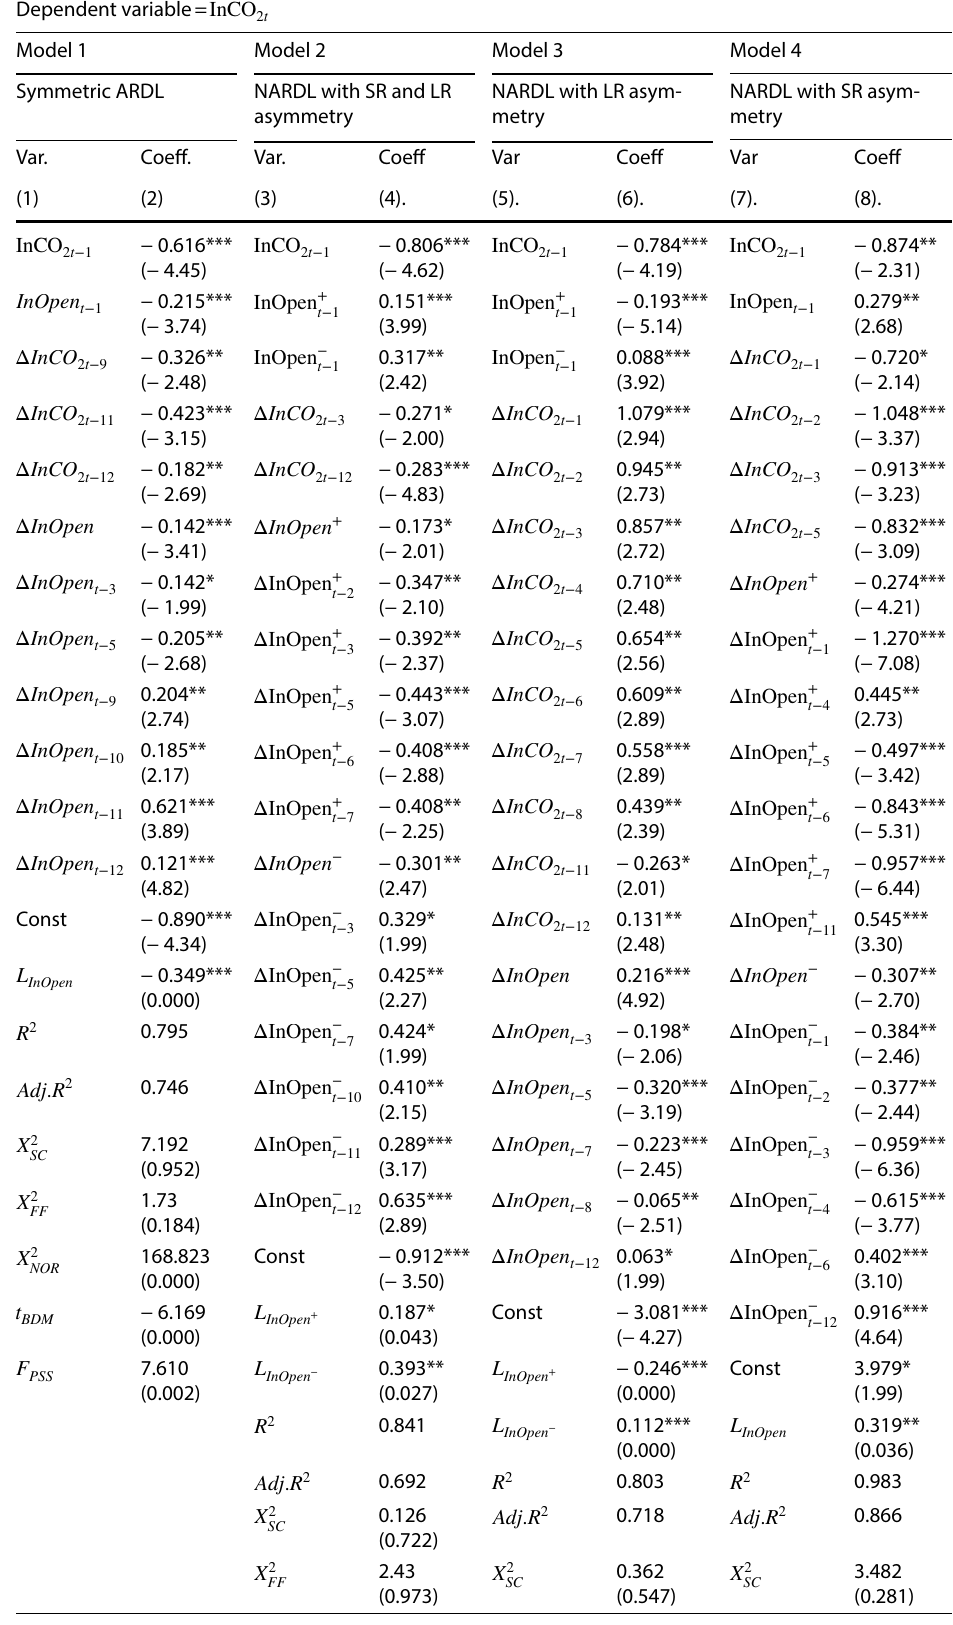
Table 8 Full-information estimates of both symmetric ARDL and nonlinear ARDL (NARDL) models in